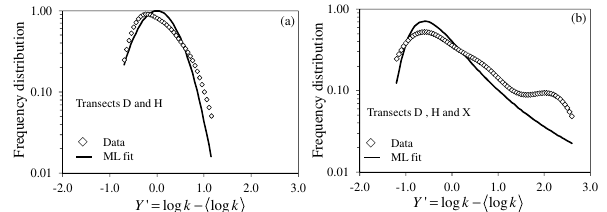
Fig. 9. Frequency distribution (symbols) and ML estimated prob- ability density function (curves) of Utah Y 0 = log k −h log k i data on horizontal (a) transects D and H (bioturbated sandstone) and (b) transects D, H and X (bioturbated sandstone and cross-bedded sandstone). Transects D and H fitTransects D, H and X × Data ML